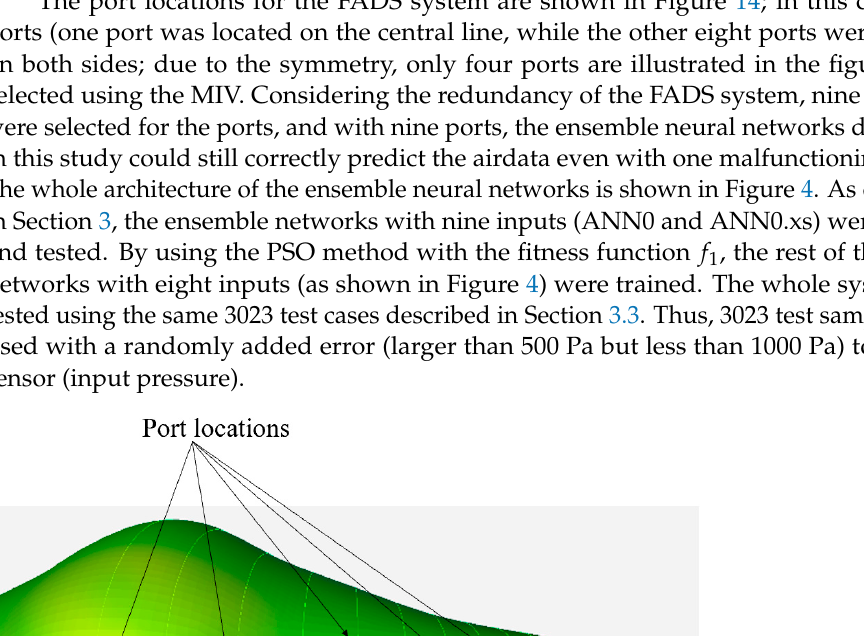
Table 6. Comparisons of the prediction results with and without error detection.